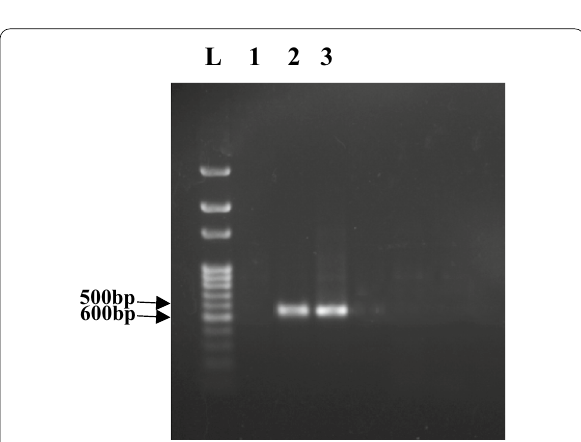
Fig. 2 Amplification of 16s rRNA region of the Bacillus isolates using Bacillus species-specific primers BCF1 and BCR2; Lane L: 100-bp ladder (Himedia MBT049); Lane 1–3: 1